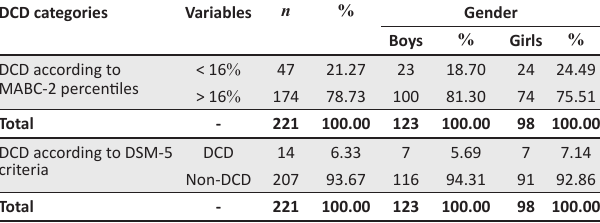
TABLE 1: Percentage of learners in different developmental coordination disorder categories in the group and by